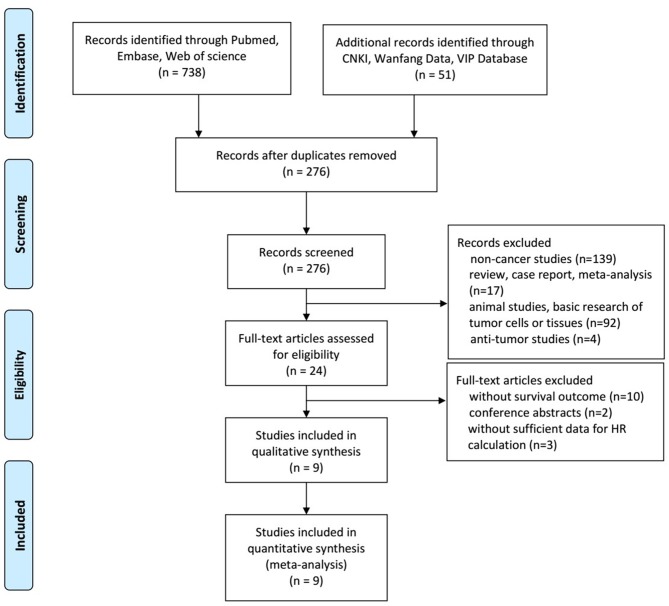
Flow diagram for selection of studies.